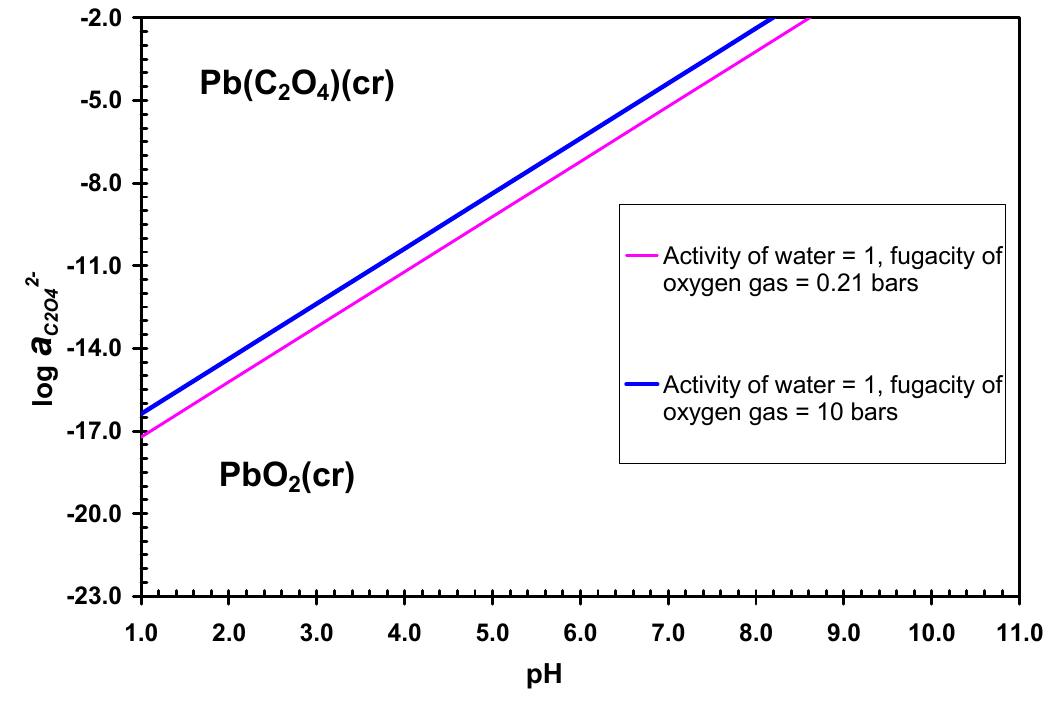
Figure 4. The stability fields of lead dioxide [PbO 2 (cr)] and lead oxalate [PbC 2 O 4 (cr)] at 25 °C in the space of pH versus log a C 2 O 4 − in an oxalate-dominated solution for desulphurization of lead pastes at water activity of 1.0 with two oxygen fugacities ( f O2 ) at 0.21 bars and 10 bars, respectively.